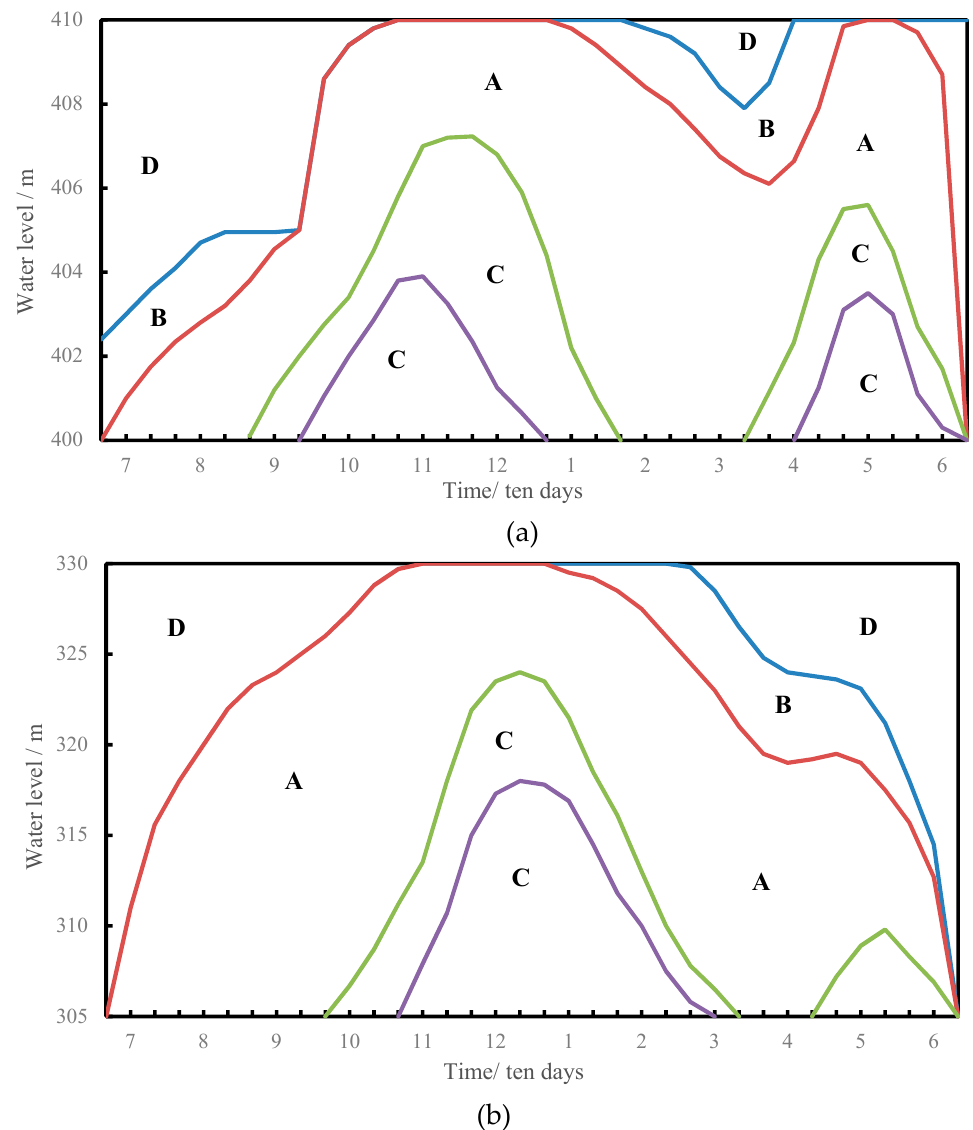
Figure 2. Conventional hydroelectric operation charts for Shiquan (a) and Ankang (b). The red line and green line are the upper basic line and lower basic line, respectively. The blue line and the purple line are the 1.2 Ng and 0.8 Ng line, respectively.